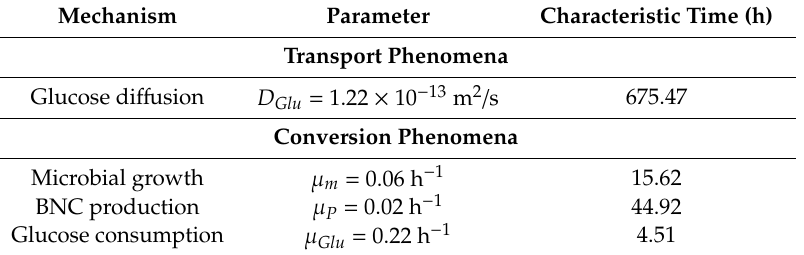
Table 4. Characteristic time for BNC production under optimized culture conditions.